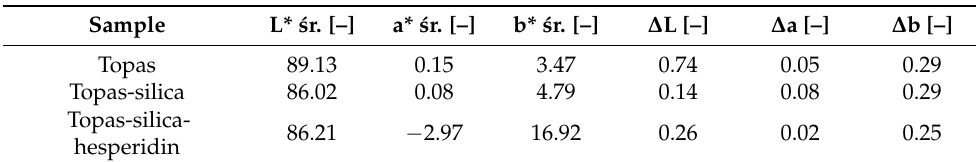
Table 2. Influence of silica and hesperidin on the colour parameters (L*, a*, b*) of Topas vulcanizates before aging.